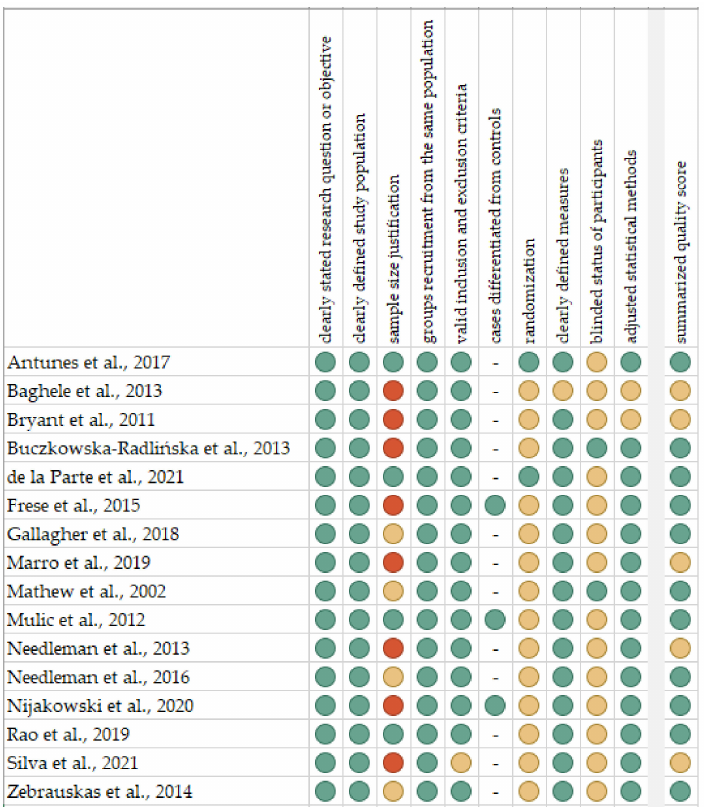
Figure 1. Quality assessment, including the main potential risk of bias (risk level: green—low, yellow—unspecified, red—high; quality score: green—good, yellow—intermediate,